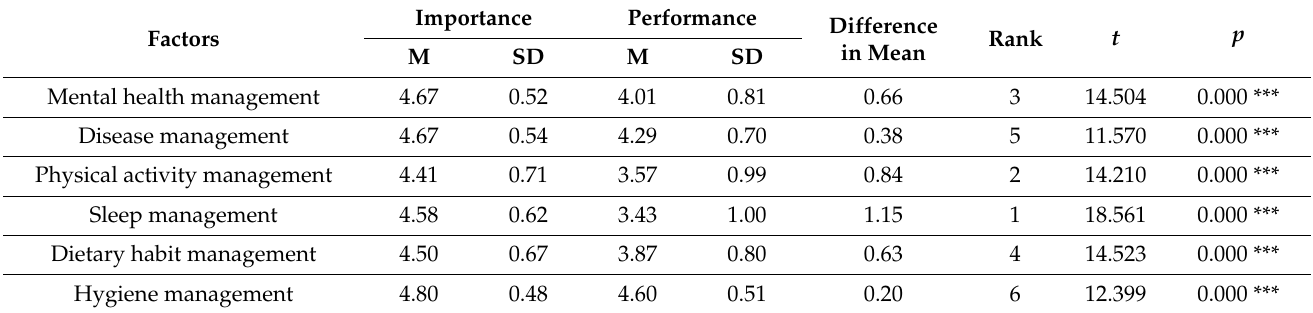
Table 4. Differences in the importance–performance of health awareness in the C middle school students participating in the interactive PE